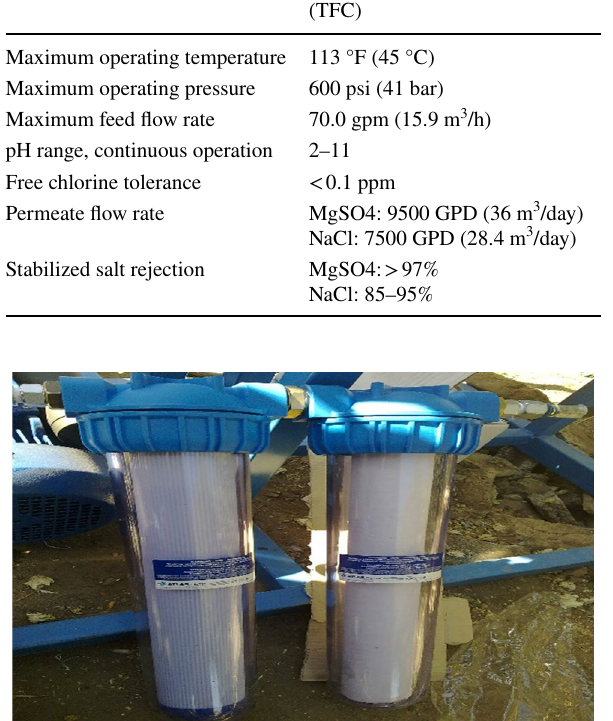
Fig. 4 Pre-treatment system